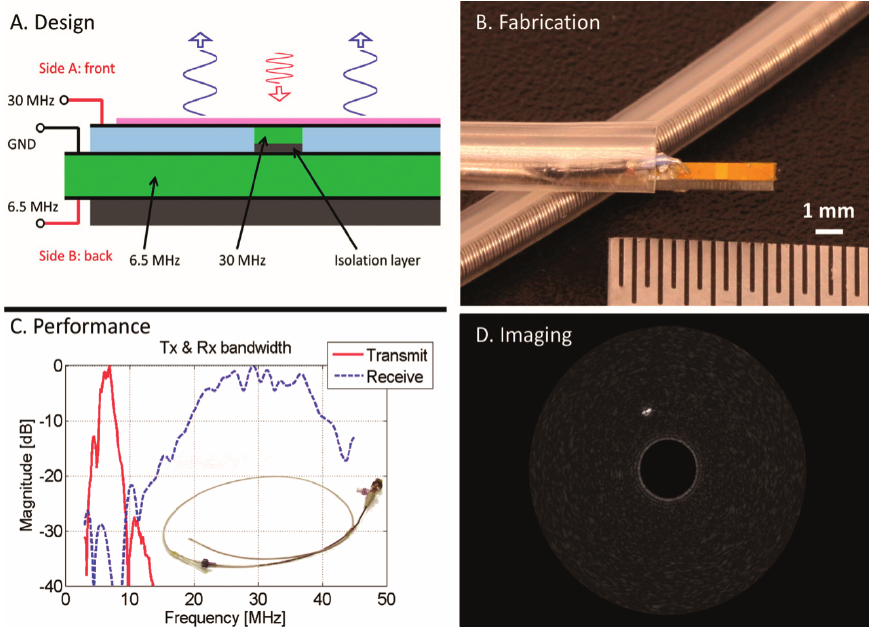
Figure 5. Dual-frequency IVUS transducer designed for superharmonic imaging. ( A ) Structure of the transducer with stacked dual layers of piezoelectric plates; ( B ) The fabricated prototype mounted in an 8.5 F commercial catheter; ( C ) Use of two elements with separate bandwidths allows coverage of the transmitting and receiving frequencies needed for the superharmonic imaging; ( D ) Contrast enhanced IVUS imaging with microbubbles in phantom with fully-developed speckle. Figure reprinted with permission from [80], front